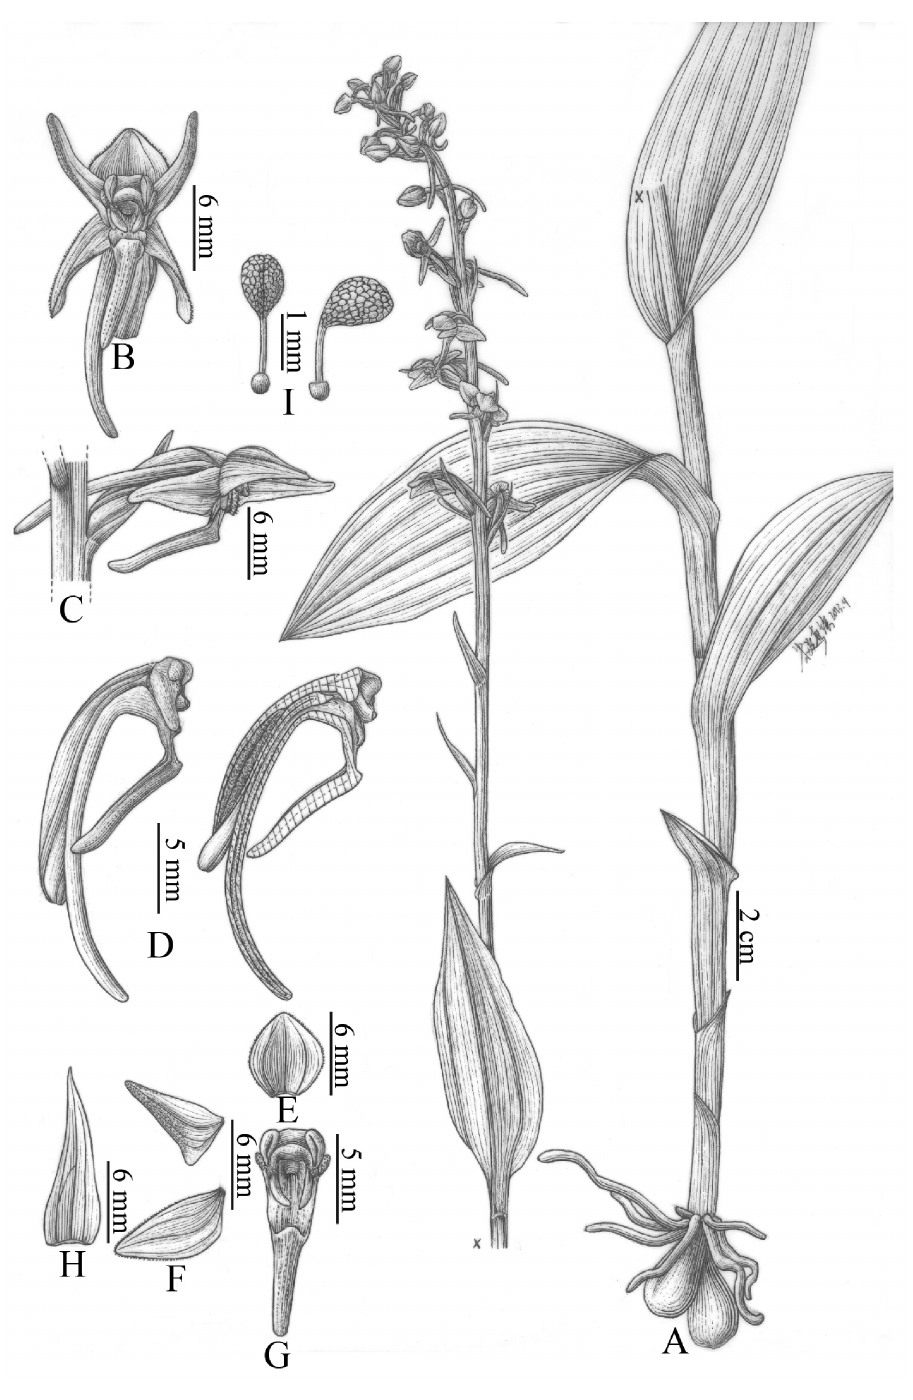
Figure 14. Herminium latilabre . A Flowering plant B Flower (front view) C Flower (side view) D Ovary with lip and spur (side view) E Dorsal sepal F Lateral sepal and petal G Lip H Floral bract I